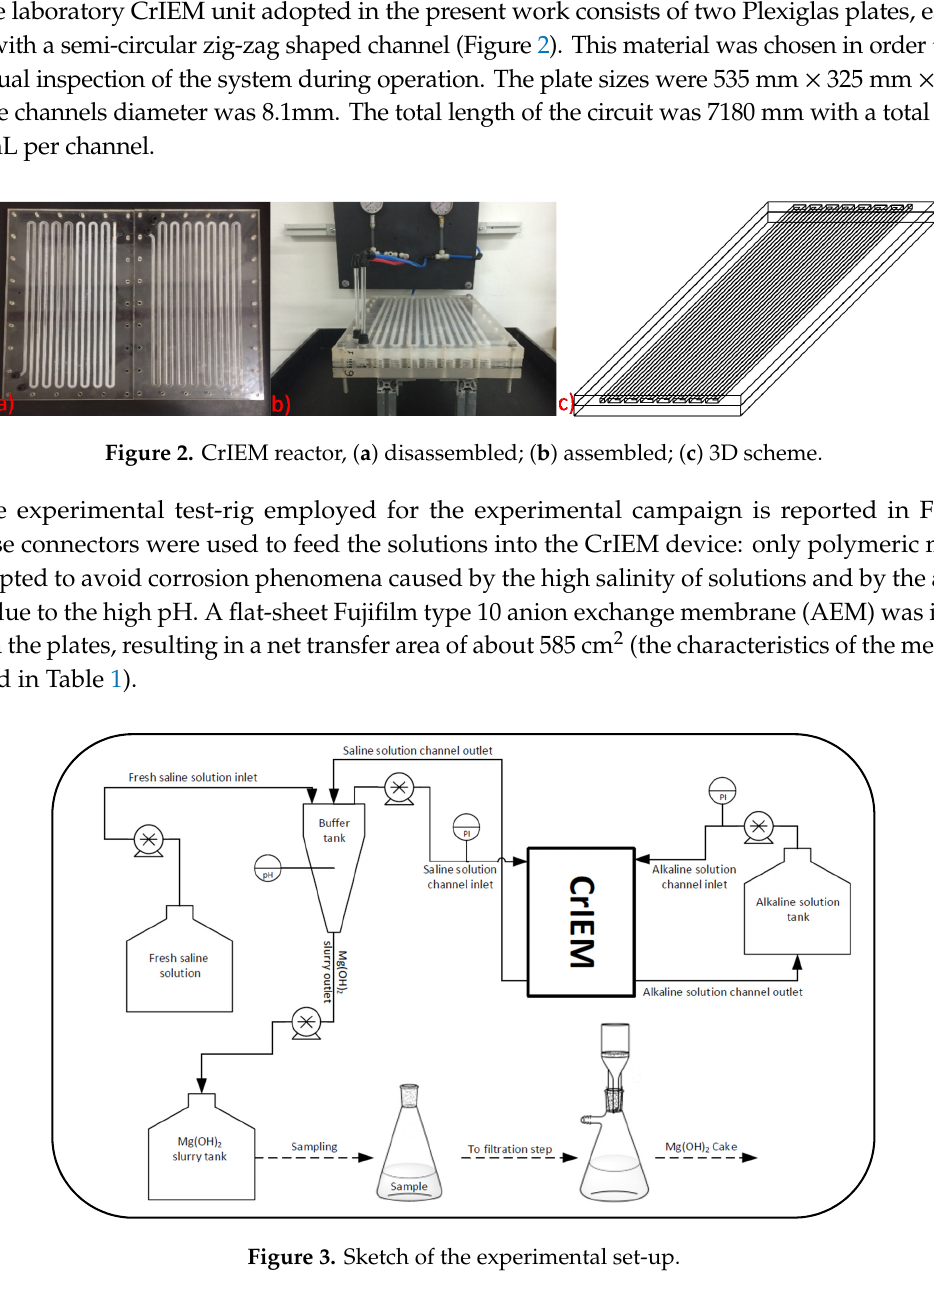
Figure 1. Process scheme of the ion exchange membrane crystallizer (CrIEM) technology for the precipitation of Mg(OH) 2 from Mg-rich brines.